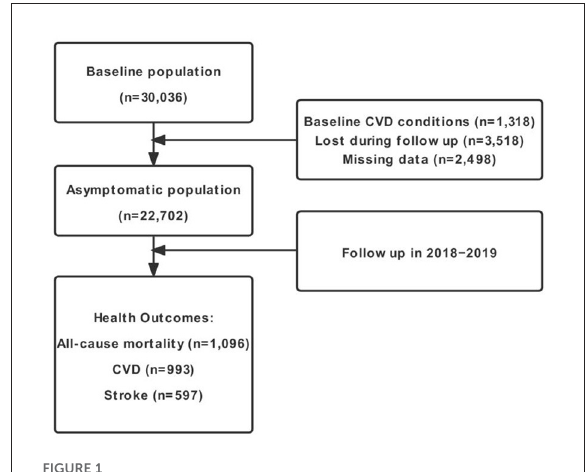
FIGURE1 Flow diagram of study inclusion. CVD, cardiovascular